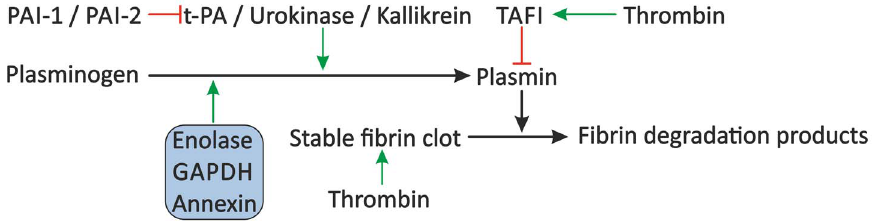
Figure 4. Proposed modulation of the fibrinolytic system by schistosomes. The fibrinolytic system inhibits blood coagulation through degradation of the formed fibrin clot by plasmin. Plasminogen is cleaved to plasmin by plasma kallikrein, but mainly by t-PA and urokinase, which are inhibited by PAI-1 and PAI-2. Furthermore, plasmin activity is inhibited by TAFI. Schistosomes may stimulate fibrinolysis by the presence of enolase, GAPDH, and annexin, which bind plasminogen and facilitate its conversion to plasmin by t-PA. Green arrows indicate stimulation. Inhibition is indicated by the red lines. Schistosome proteins are denoted in the shaded box. Abbreviations: tissue-type plasminogen activator (t-PA), plasminogen activator inhibitor 1 (PAI-1) and 2 (PAI-2), thrombin-activatable fibrinolysis inhibitor (TAFI), glyceraldehyde-3-phosphate dehydrogenase (GAPDH).